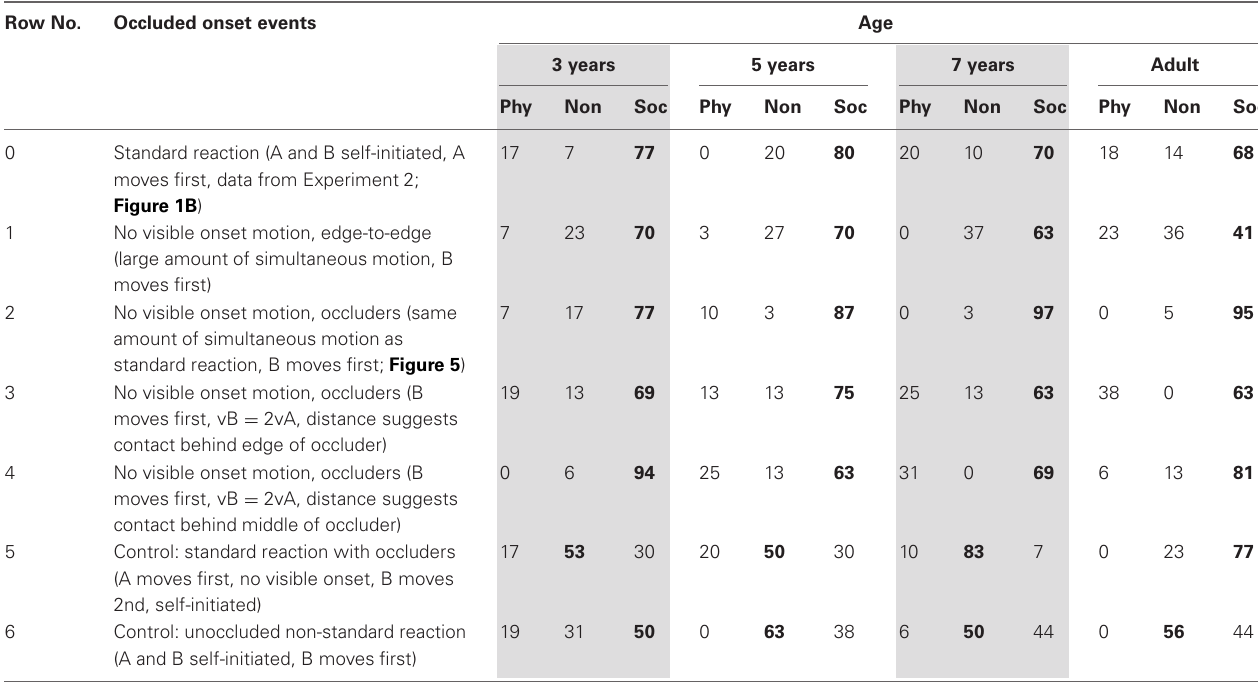
Table 3 | Percentage of physically causal, non-causal, and socially causal attributions, in 4 age groups, for 4 events showing motion-at-a-distance without visible motion onset, and for 3 other events in Experiment 3. Row